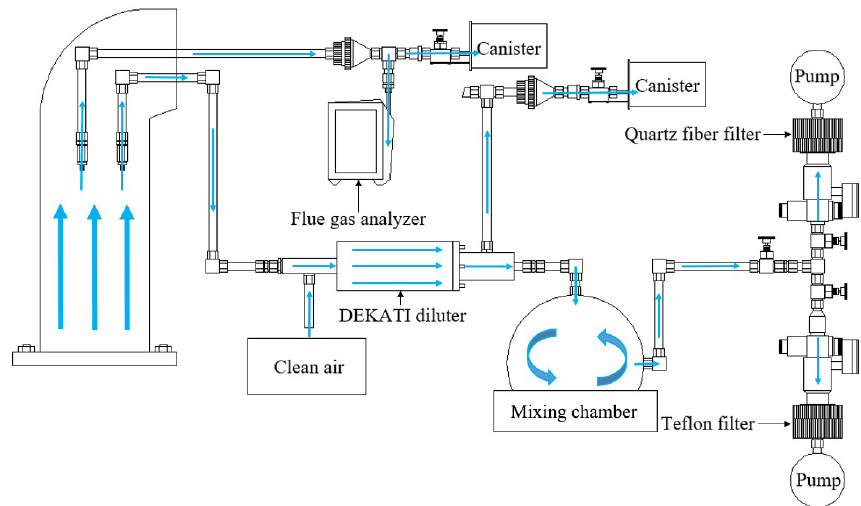
Figure 2. Schematic diagram of sampling